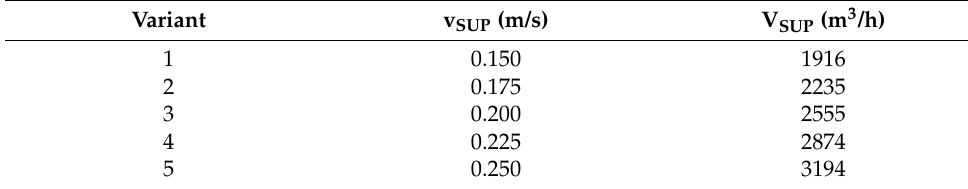
Table 3. Air flow of the laminar field for individual variants.